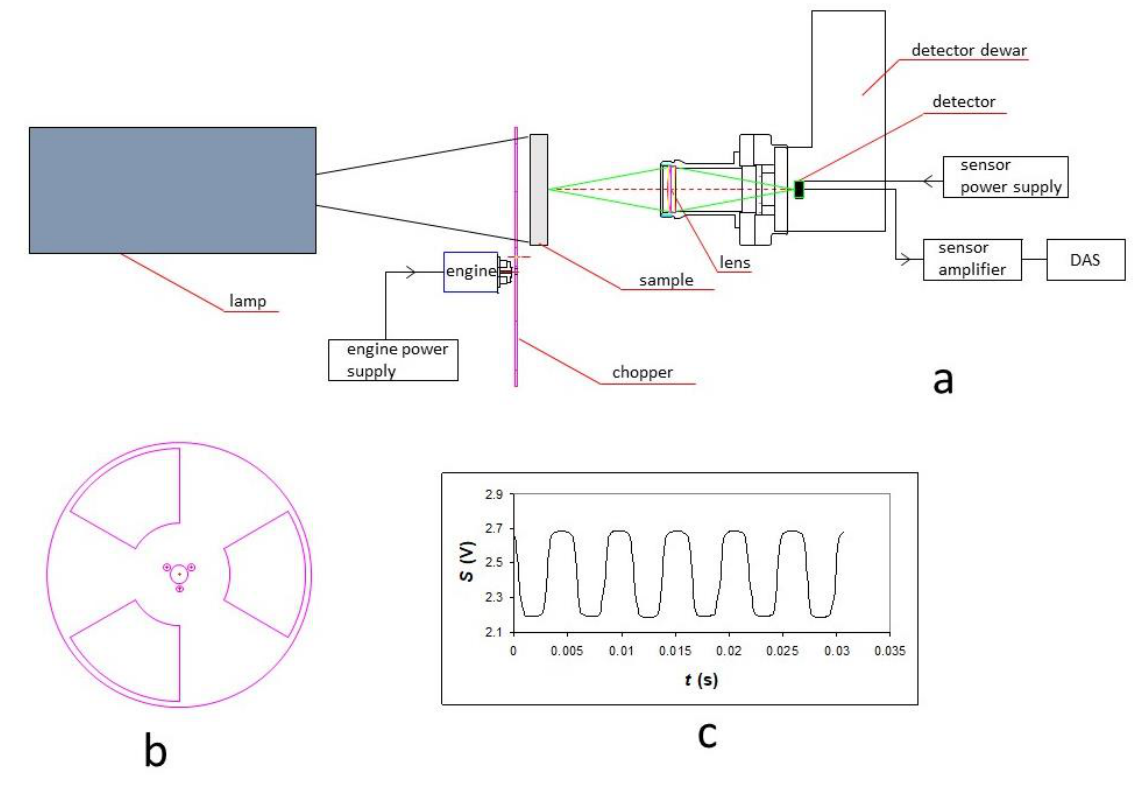
Figure 10. ( a ) Schematic of the experimental apparatus; ( b ) chopper; ( c ) detector signal.